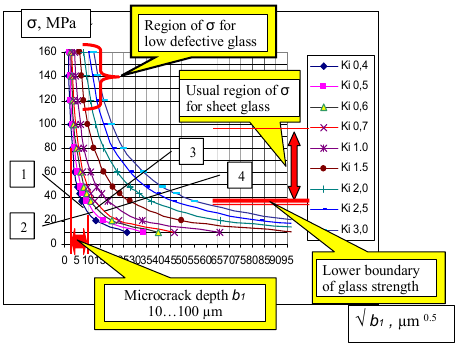
Figure 4: The calculated dependences of the bending strength of glass plates subject to the depth of semi-elliptical surface micro-crack in a fracture